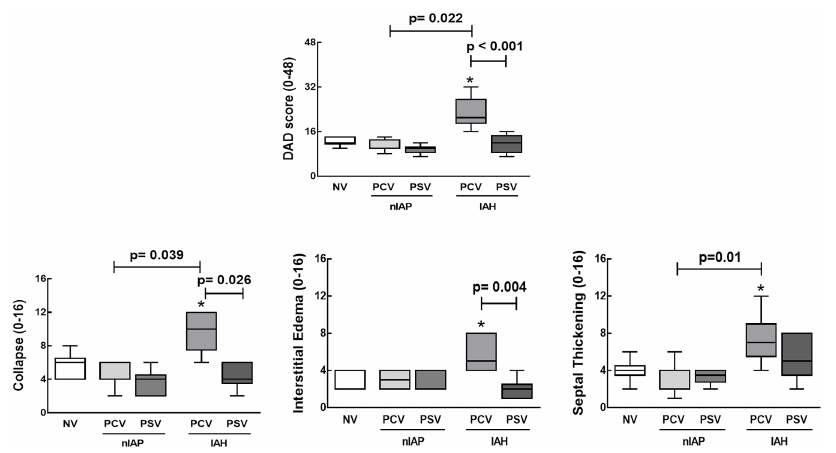
Fig 2. Cumulative DAD score (scoresarithmetically averagedfrom two independent investigators) representing injury from alveolar collapse, interstitial edema, and septal thickening in animals with normal intra-abdominal pressure (nIAP) or intra-abdominal hypertension (IAH) mechanically ventilated in pressure-controlled ventilation (PCV) or pressuresupport ventilation (PSV) mode. NV: non-ventilated animals. Values are given as medians,interquartile ranges, and minimum/maximum of 6 animalsin each group. Statistical significancewas acceptedat p < 0.05. * Significantly different from